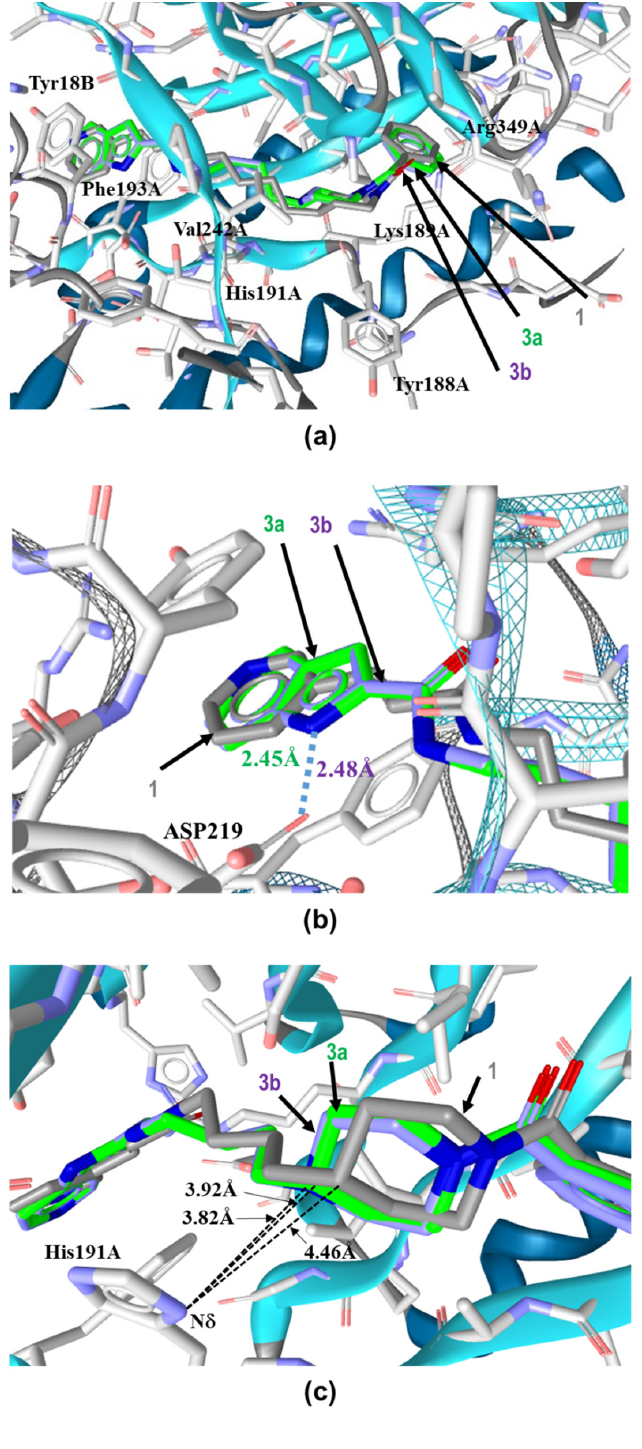
Figure 4. Binding modes of 3a , 3b and 1 in the tunnel cavity of NAMPT. ( a ) Binding modes of 3a, 3b and 1 in the tunnel cavity of NAMPT were analyzed by our in silico binding mode analysis using RDKit [48] and LigandScout [49]. ( b ) Close-up view of head regions of these three NAMPT inhibitors in the tunnel cavity of NAMPT using Open3DALIGN [53]. ( c ) Close-up view of the binding interactions of azacyclohexane-linker moieties of these NAMPT inhibitors with His191A located in the tunnel cavity of NAMPT. Carbons are colored green ( 3a ), magenta ( 3b ) and gray ( 1 ). Nitrogen and oxygen are colored blue and red, respectively.